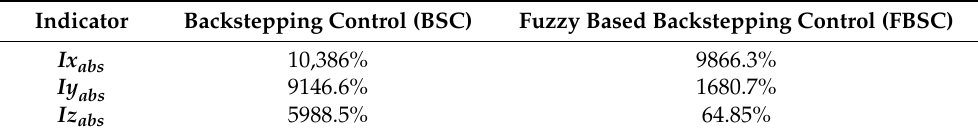
Table 5. Integral Absolute Error Values with Disturbances.